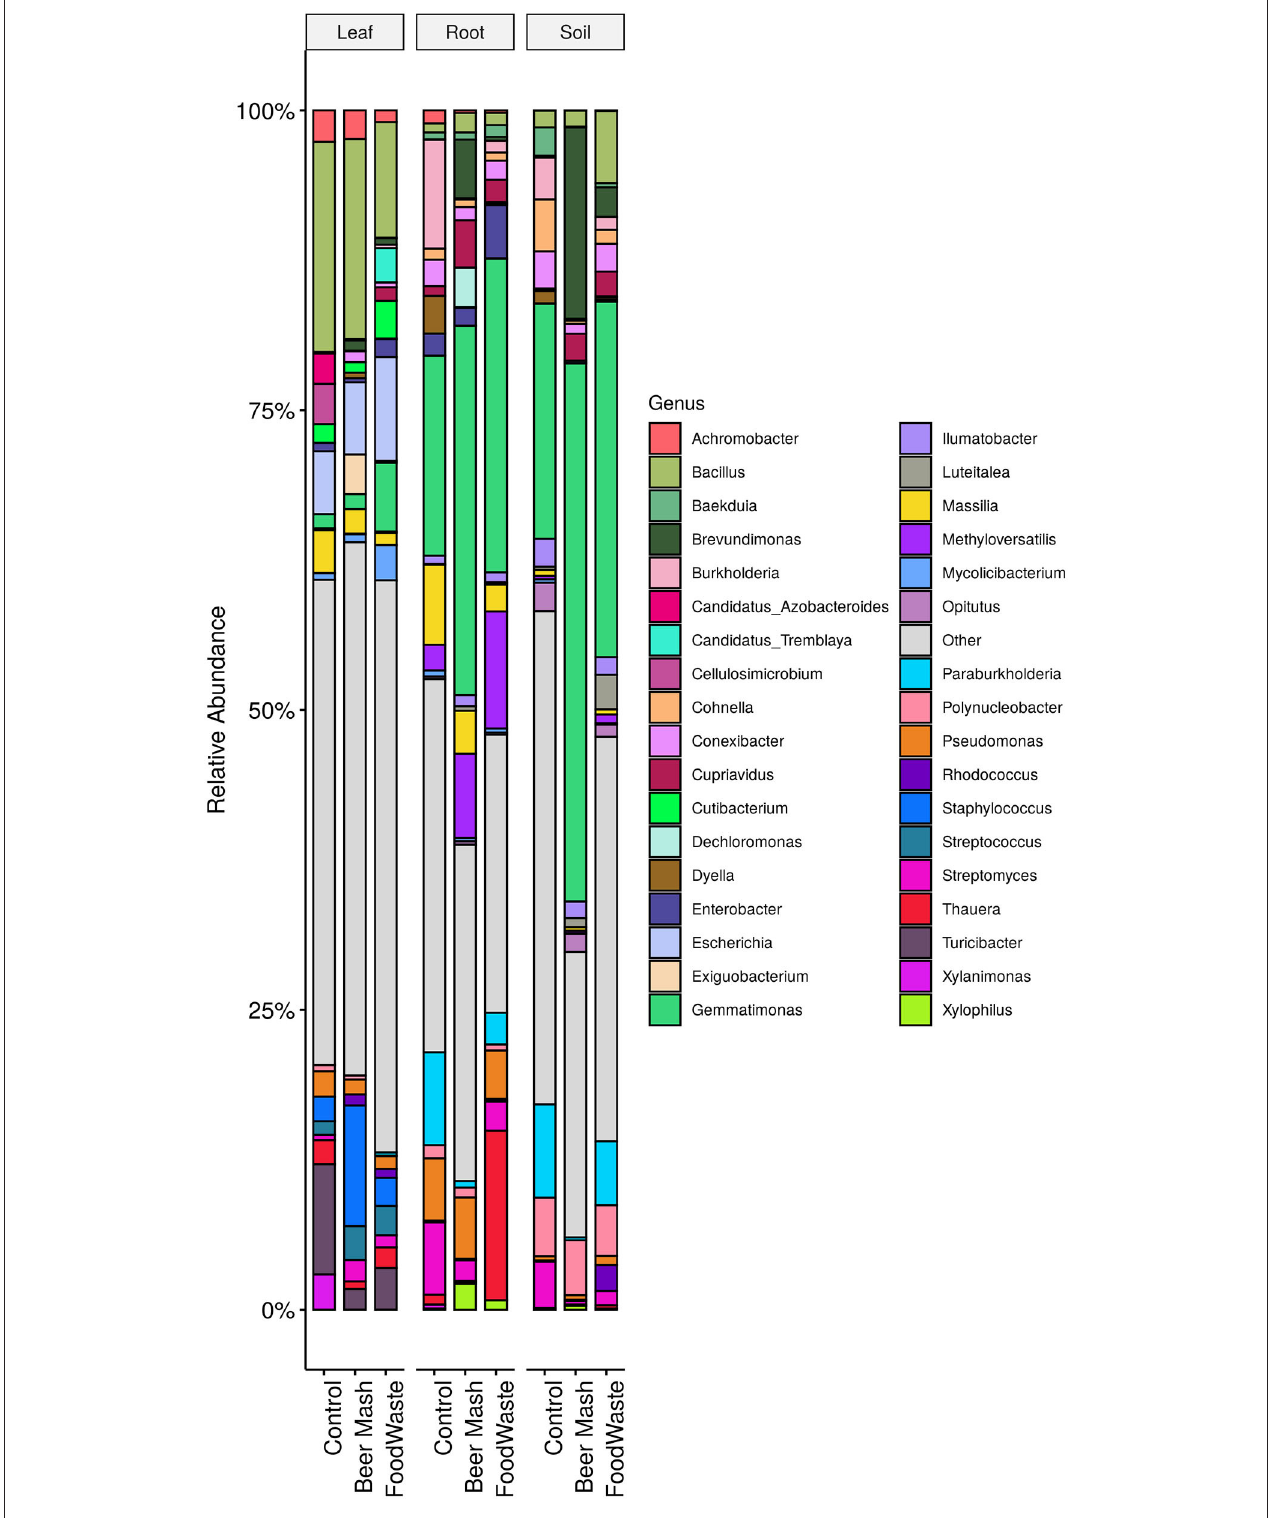
FIGURE 4 | Stacked column bar graph representing the relative abundance and distribution, at the end of the greenhouse experiment, of the 15 most abundant genera from each tissue type, leaf, root and potting soil, treated with food waste and beer mash digestate or not treated (control). Samples were taken 2 weeks after the last FW and BM digestate application into the